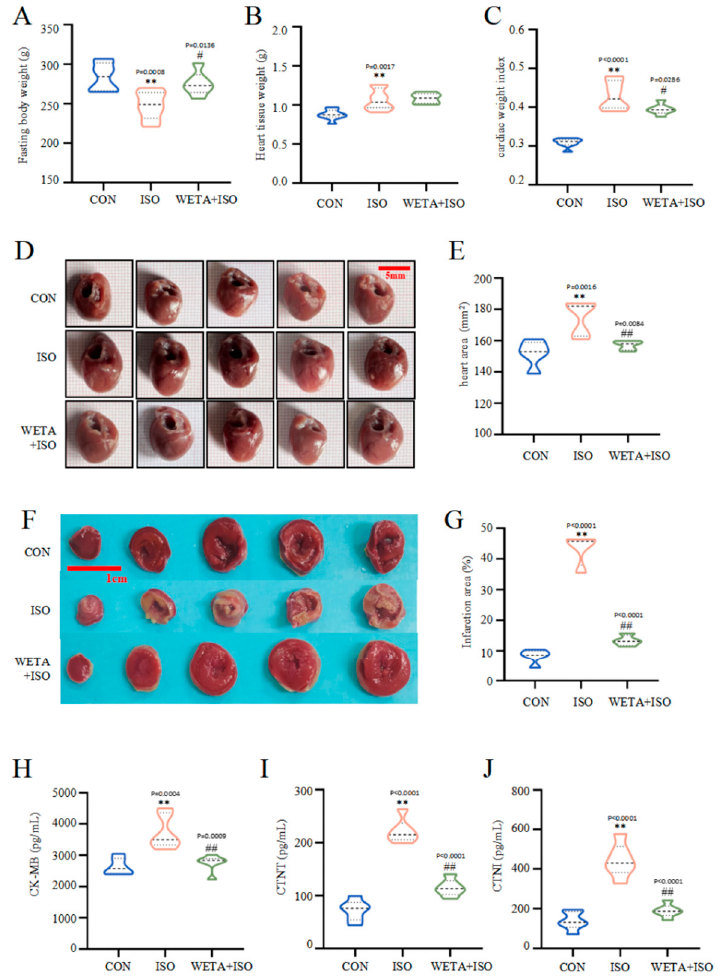
Figure 4. WETA reduced heart deformation and cardiac damage markers. ( A ) Fasting body weight, ( B ) heart tissue weight, ( C ) cardiac tissue index (cardiac weight index (CWI) was calculated according to the following formula: CWI(g/g) = heart tissue weight (g)/body weight (g) × 100), ( D ) representative heart shape (scale bar = 500 µ m), ( E ) heart area, ( F ) representative TTC-stained sections (Scale bar = 1 cm), ( G ) heart infarction area, the serum levels of CK-MB ( H ), cTNT ( I ), and cTNI ( J ). Values are mean ± SD (n = 6), ** p < 0.01 vs. CON group; ## p < 0.01, # p < 0.05 vs. ISO group, using one-way ANOVA.